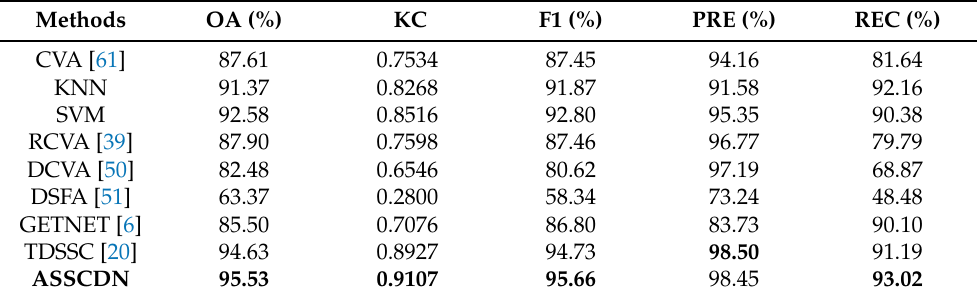
Table 3. Quantitative comparison results of various methods applied on the Bay dataset.